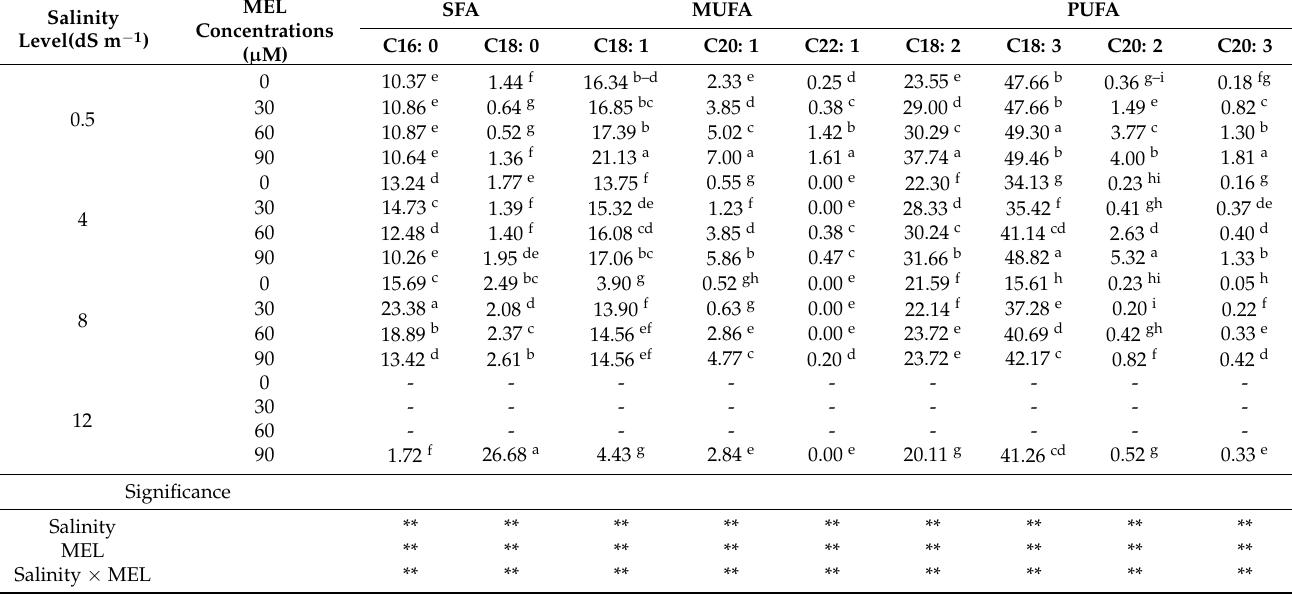
Table 3. Effects of MEL foliar applications (0, 30, 60, and 90 µ M) on the fatty acid composition of camelina seeds in plants grown under different levels of salinity (0.5, 4, 8, 12, and 16 dS m − 1